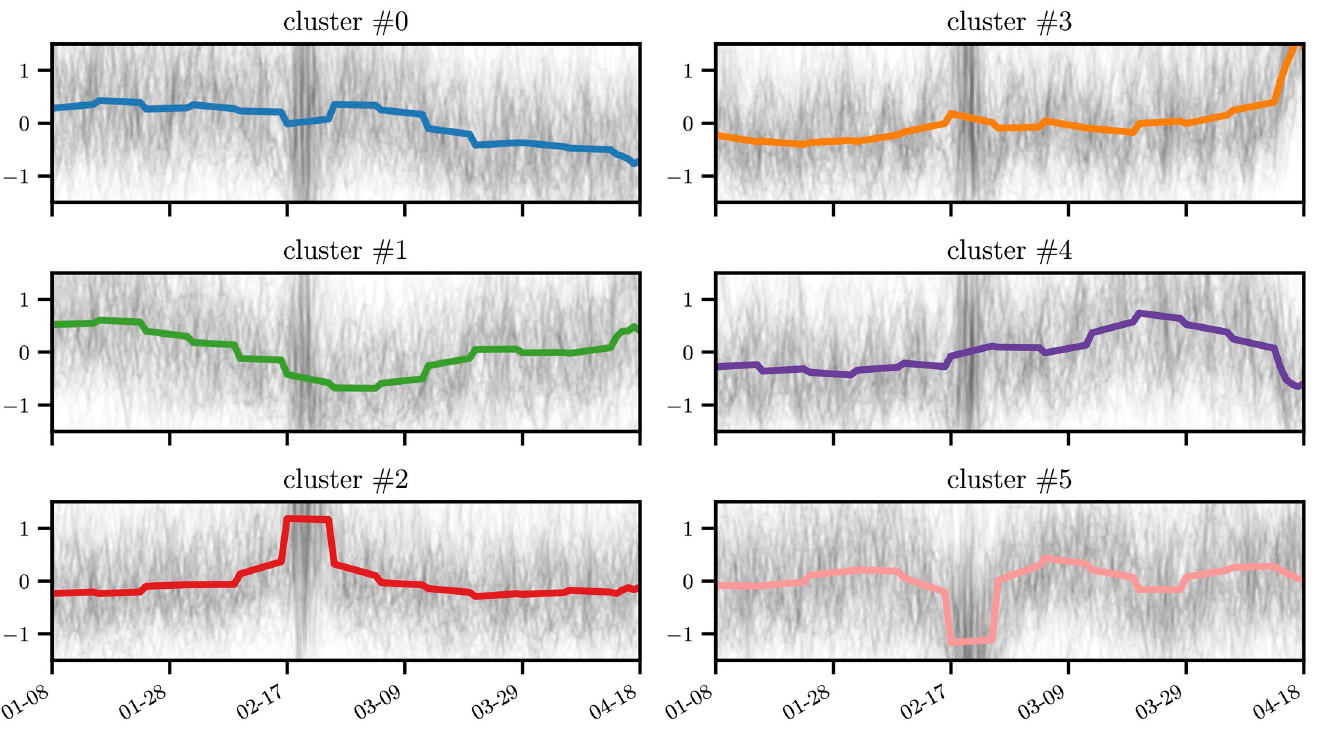
Fig 4. Time series